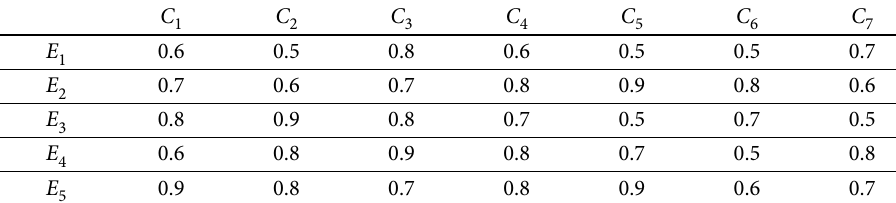
Table 3. Characteristics of the enterprises